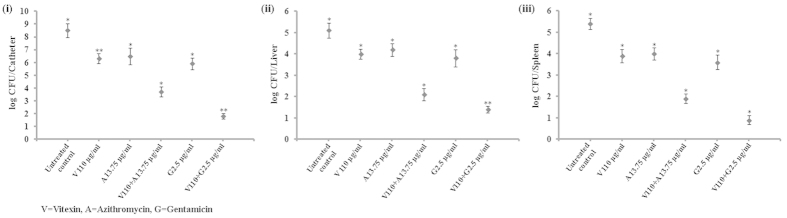
Effect of vitexin alone and in combination with azithromicin, gentamicin against in vivo catheter associated P. aeruginosa biofilm model.Data are expressed as log10CFU for isolated catheter (i), liver (ii) and spleen (iii). Each value is the average of triplicate assay where presented data is mean ± SD. Statistical analysis were done using one way ANOVA and *express P value < 0.01 and **express P value < 0.001 (n = 3).